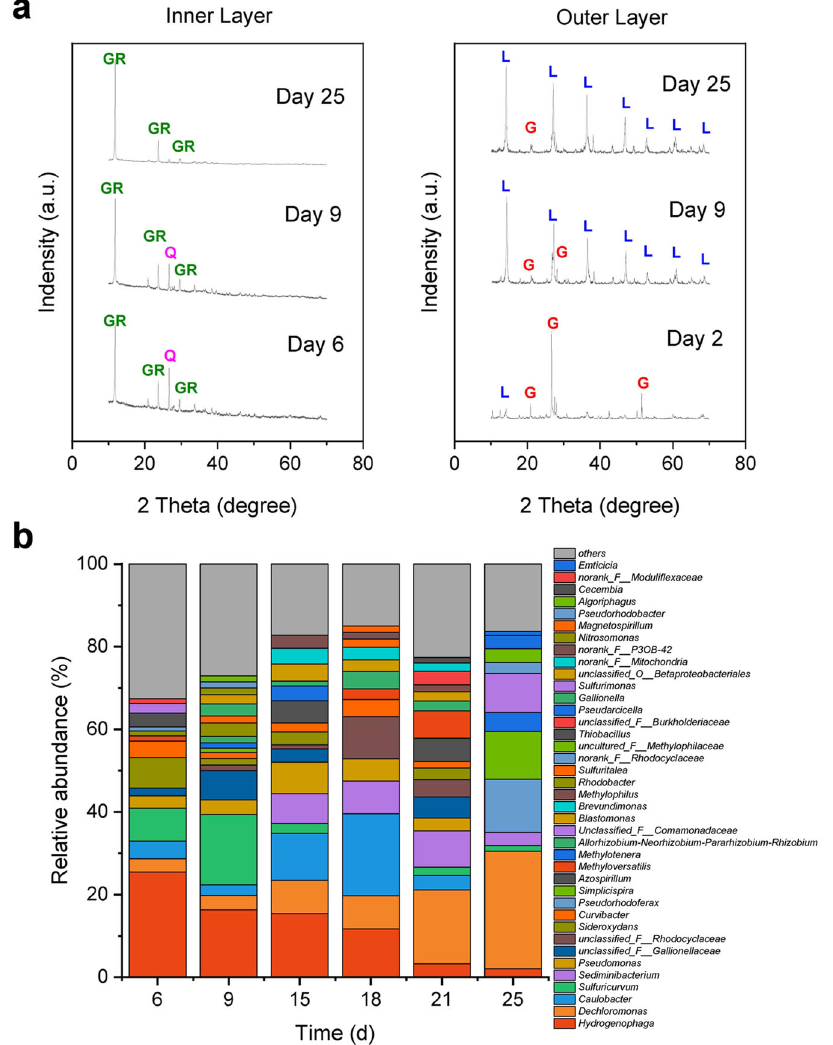
Fig. 5 Transformation of iron oxides and bacterial community in Fe-sediment system. a Dynamic changes of iron oxides composition in the inner layer (left) and outer layer (right) on iron rod surface after the iron rod was introduced into the sediment-water system, revealed by X-ray diffraction patterns. (G-goethite, L-lepidocrocite, GR-green rust and Q-quartz). b Evolution of bacterial community on iron rod surface during nitrate reduction. The category “ others ” represents the genera with relative abundances below